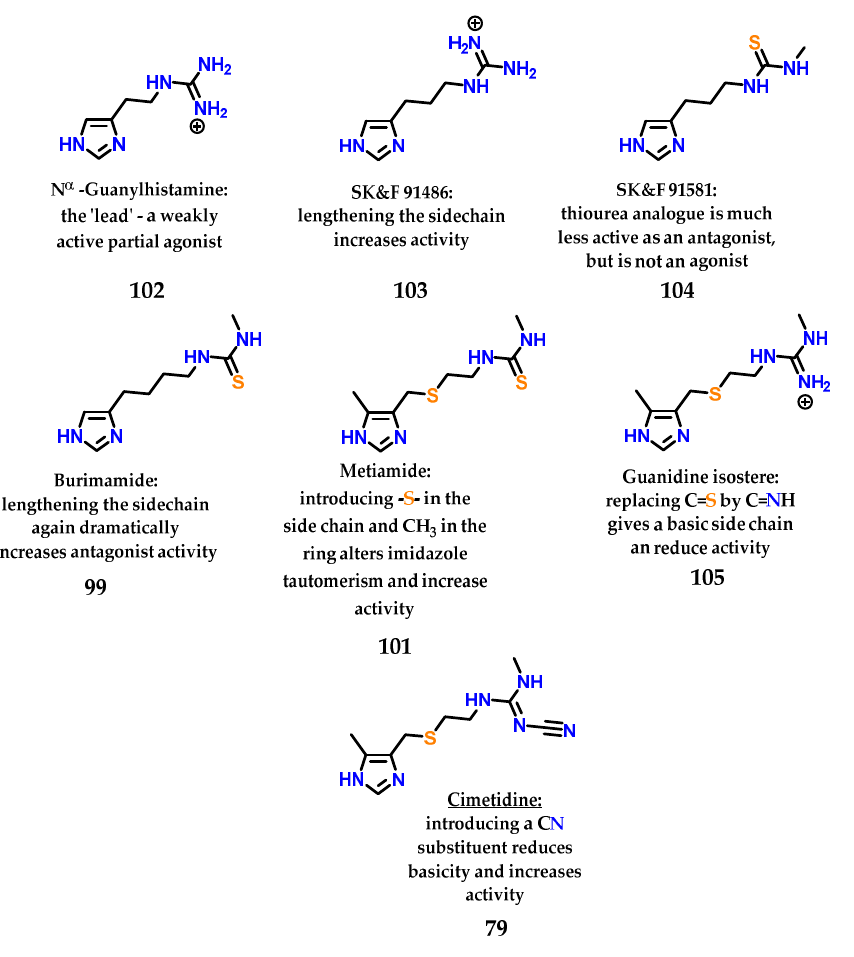
Figure 42. Sequential analogues described by Black, Ganellin and coworkers at SK&F until the discovery of cimetidine 79 .